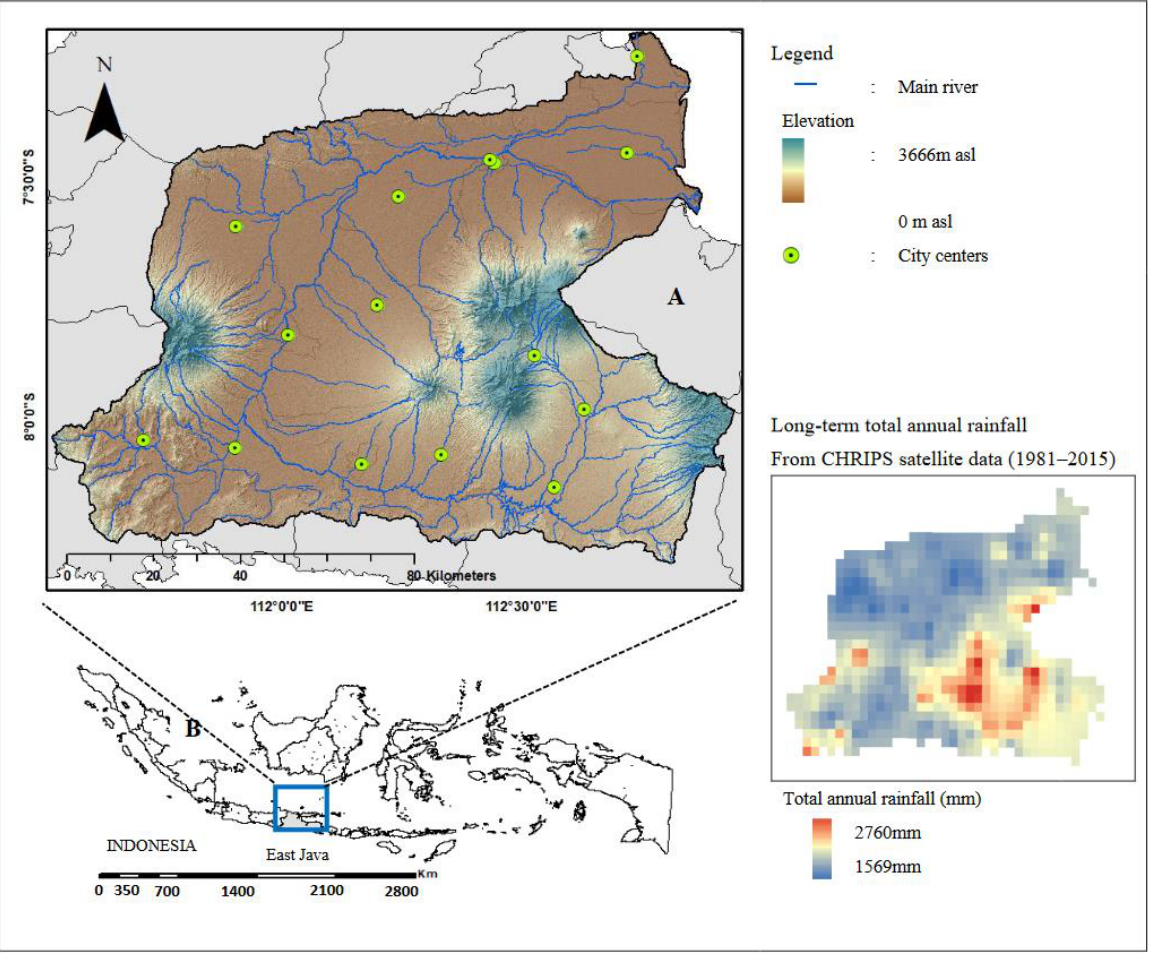
Figure 1. ( A ) The BRB within East Java. The blue lines show the main river network. The green dots are the largest cities in the BRB. ( B ) BRB orientation in Indonesia.